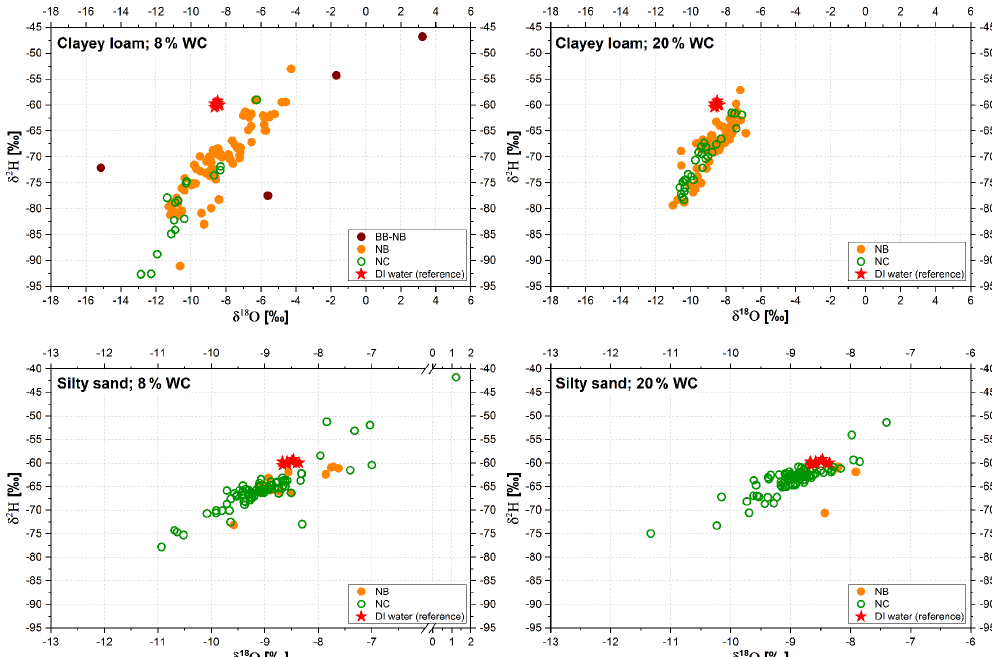
Figure 7. Dual isotope plots of clayey loam and silty sand extracts for 8 and 20%WC in comparison to reference DI water (red asterisks) for OA-ICOS analyses flagged by spectral contamination using the Spectral Contamination Identifier (LWIA-SCI) post-processing software (Los Gatos Research Inc.). BB-NB: Broad- and narrowband absorbers (ethanol and methanol); NB: narrowband absorber (methanol); NC: no contamination